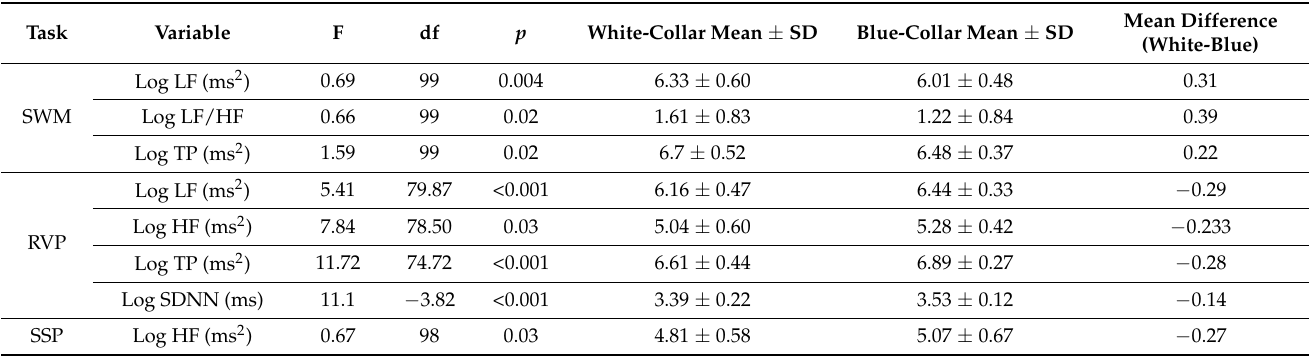
Table 3. Differences in HRV Parameters between the White ( n = 48) and Blue-collar ( n = 53) worker sample